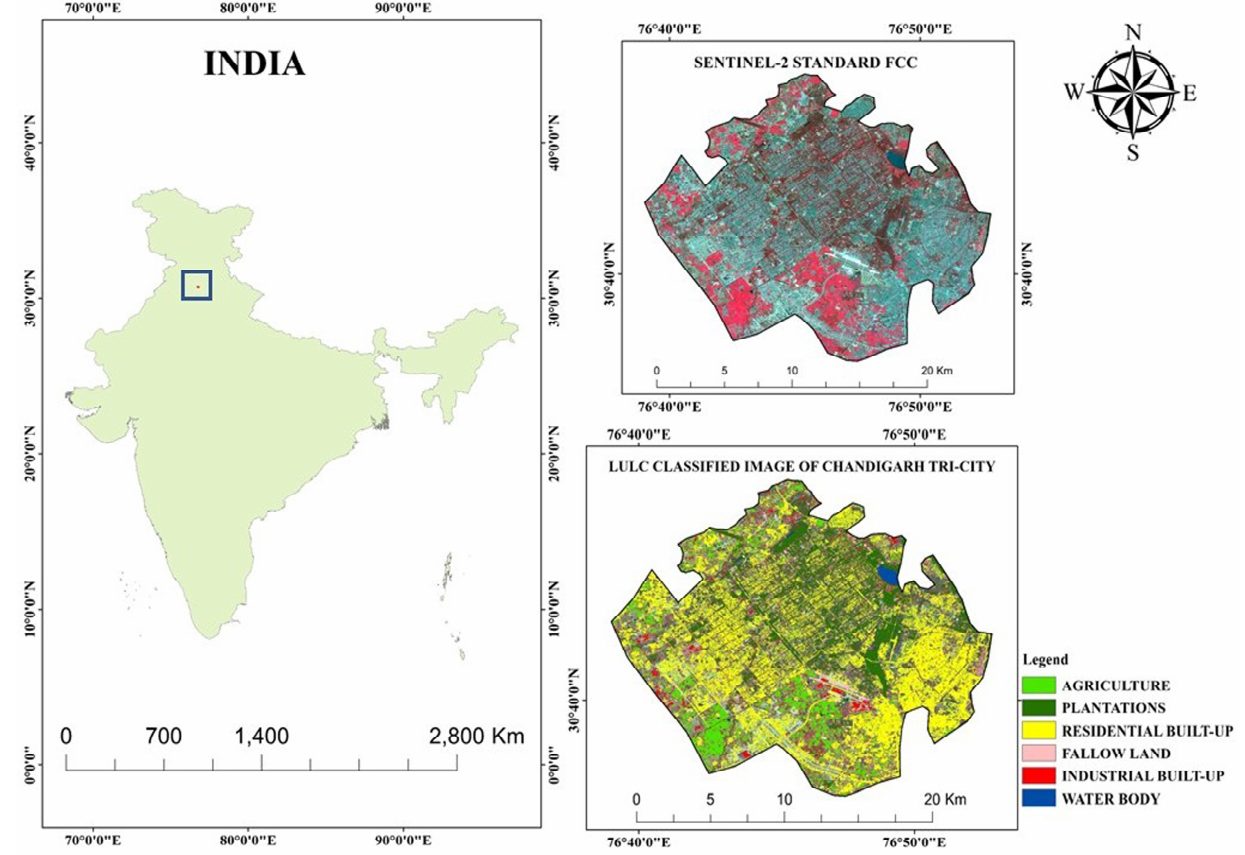
Figure 1. Study area map of Chandigarh showing Sentinel-2 standard false color composite image and land use/land cover classified imagery.